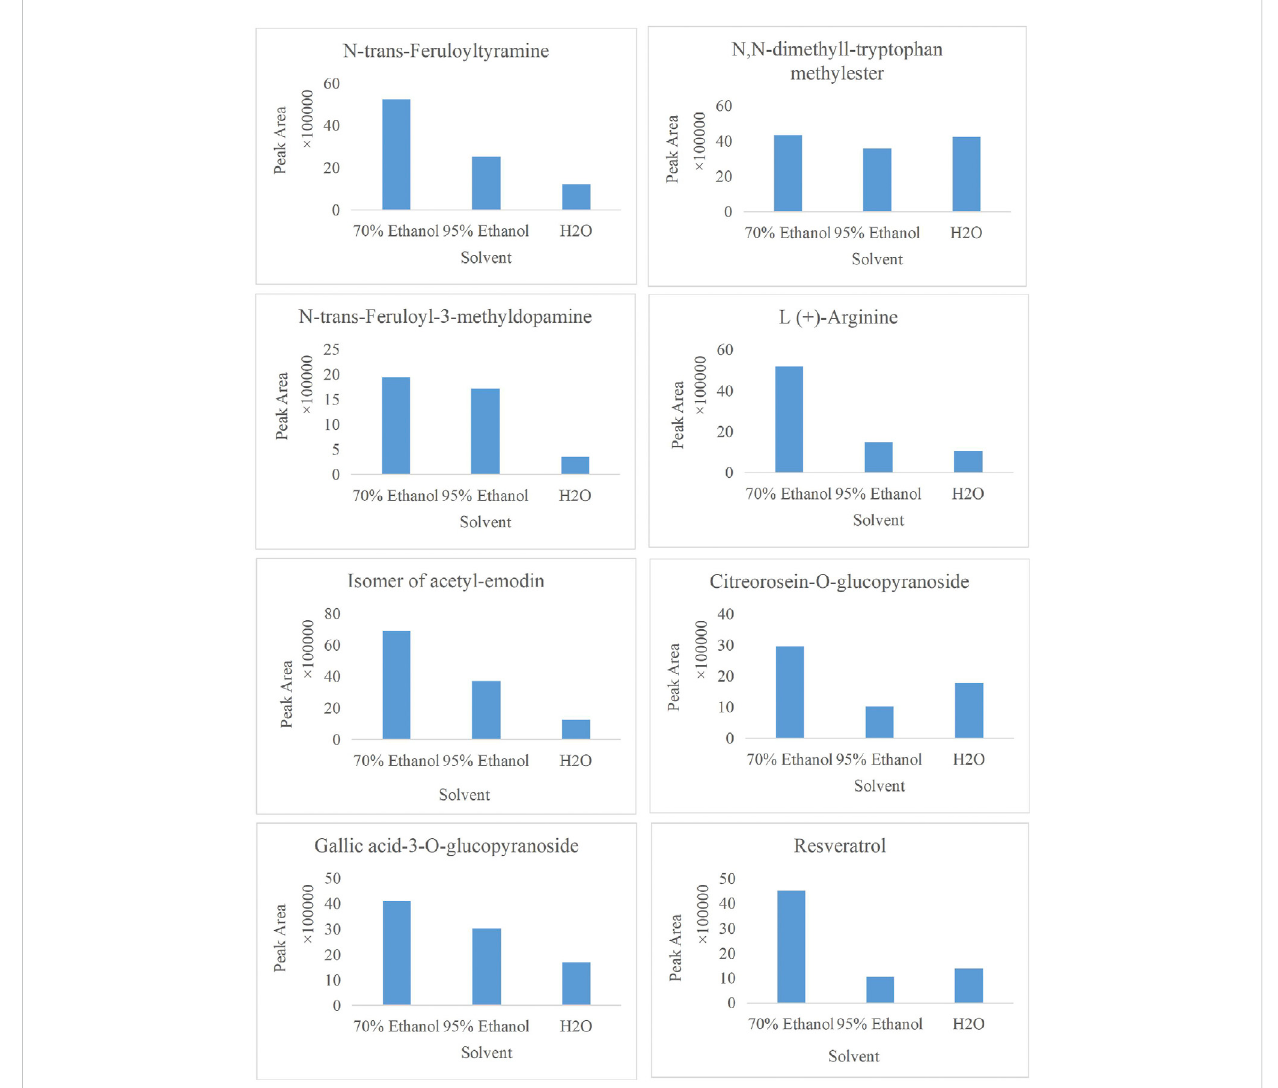
FIGURE 14 Histogram of peak area of compound N,N-dimethyl-tryptophan methylester, N-trans-feruloyltyramine, N-trans-feruloyl-3-methyldopamine, L (+)-arginine, the isomer of acetyl-emodin, citreorosein-O-glucopyranoside, gallic acid-3-O-glucopyranoside, and resveratrol in three solvents.